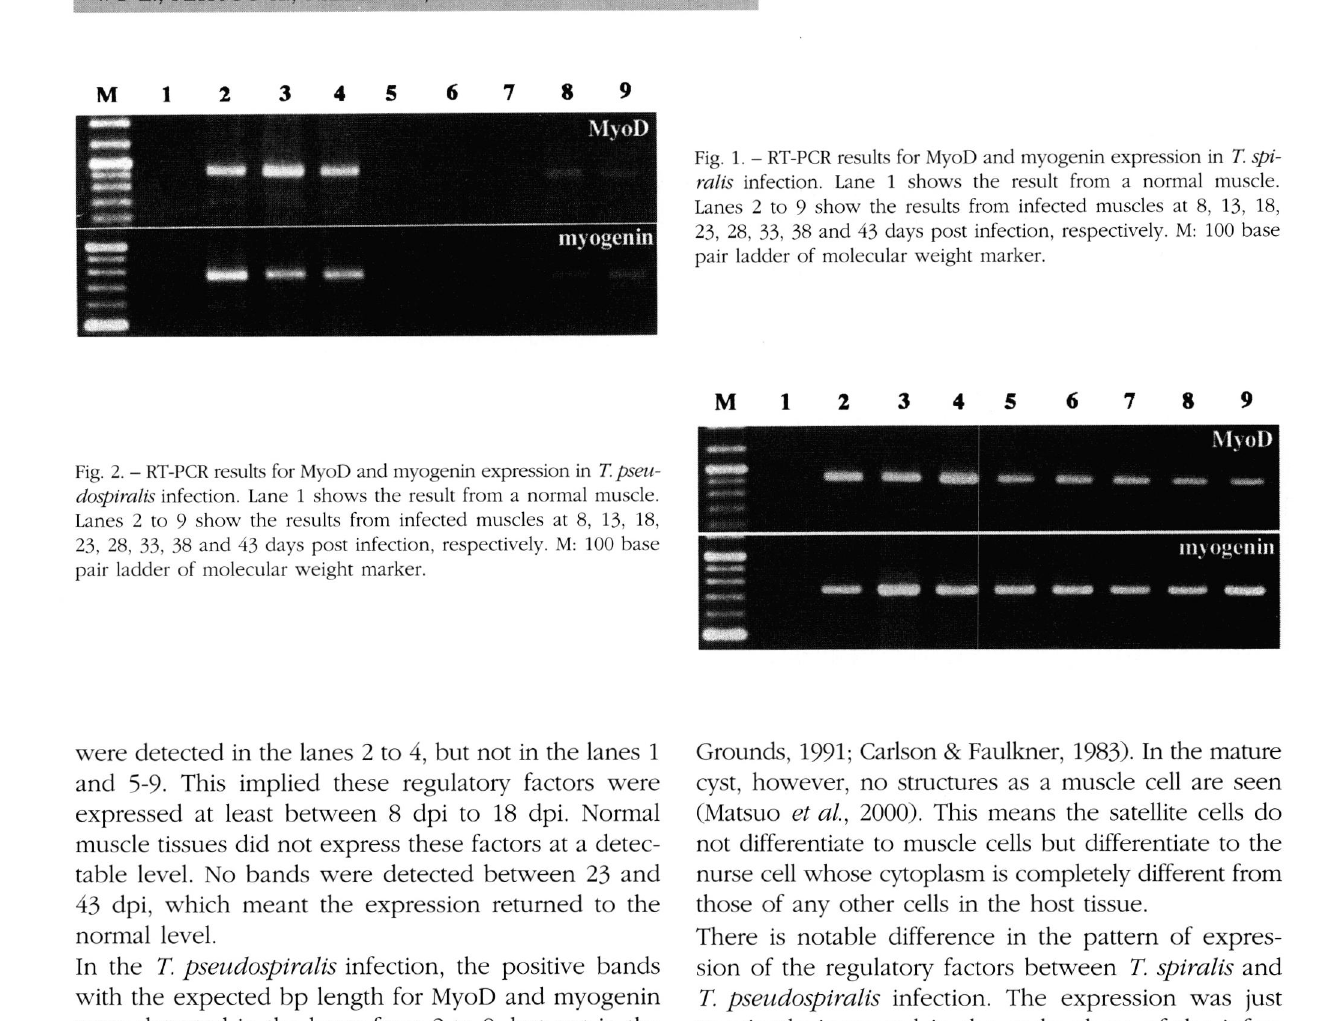
Fig. 1. - RT-PCR results for MyoD and myogenin expression in T. spi ralis infection. Lane 1 shows the result from a normal muscle. Lanes 2 to 9 show the results from infected muscles at 8, 13, 18, 23, 28, 33, 38 and 43 days post infection, respectively. M: 100 base pair ladder of molecular weight marker.